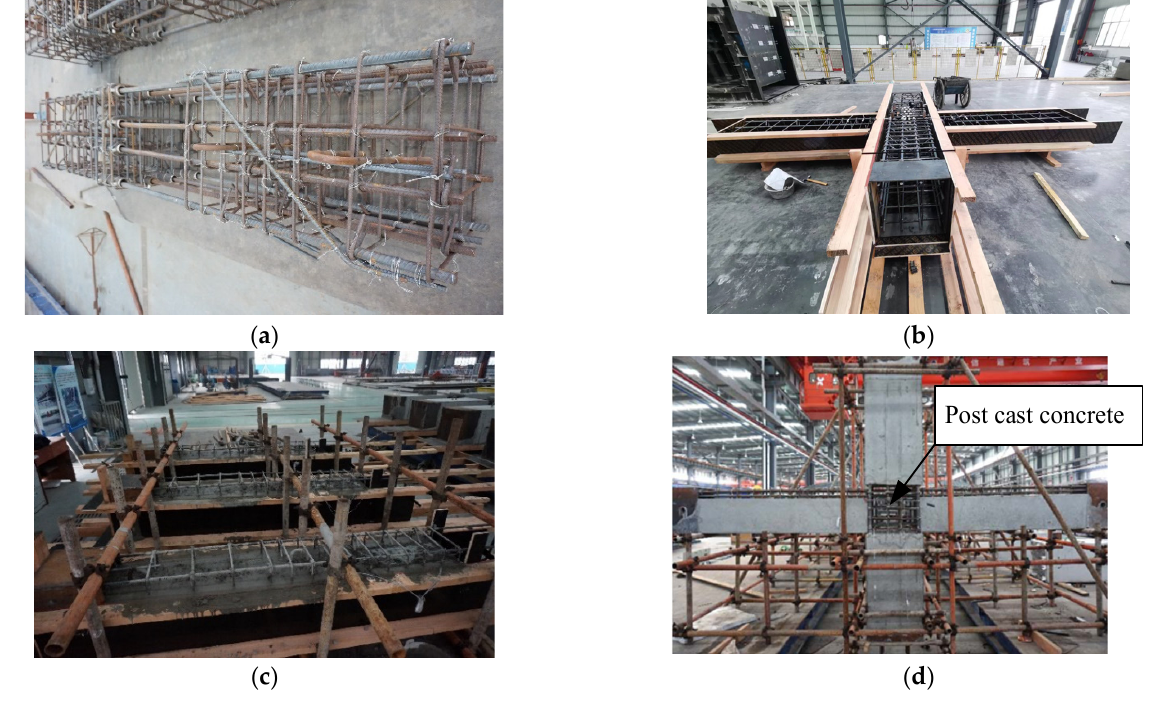
Figure 7. The specimens preparation . ( a ) Reinforcing cage for the column. ( b ) Formwork support. ( c ) Pouring concrete. ( d ) Assembly.